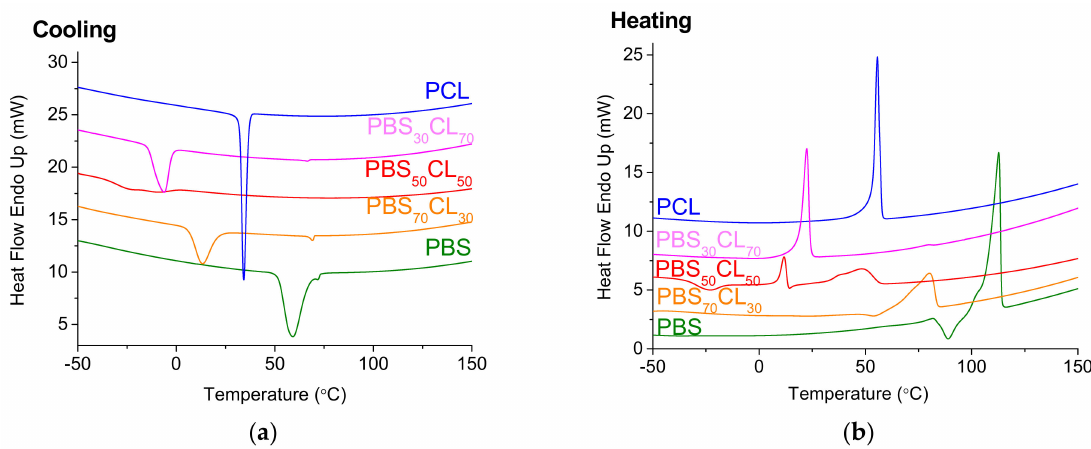
Figure 9. DSC scans of PBS, PCL, and PBS x CL y copolyesters. ( a ) Cooling from the melt showing the crystallization exotherms and ( b ) second heating scan showing the melting